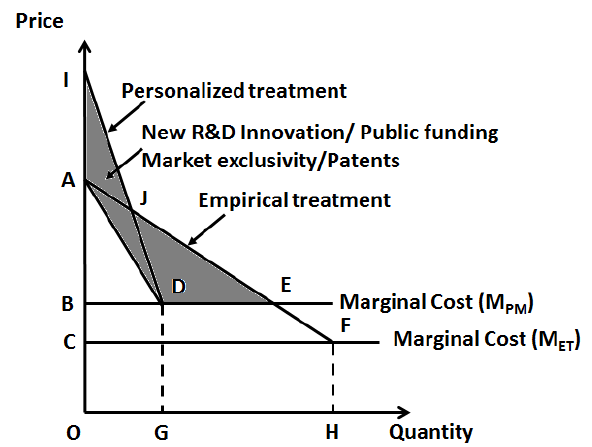
Figure 3. Potential new pricing for new molecular entities compared to empirical pharmaceutical entities. Shaded area is the potential R&D costs (amount) needed to invest upfront to bring down the prices of new molecular entities. This amount should either be recovered from short-term higher pricing of new molecular entities or investment to be done by public funding agencies like the National Institutes of Health in academic institutions to bring down the prices.